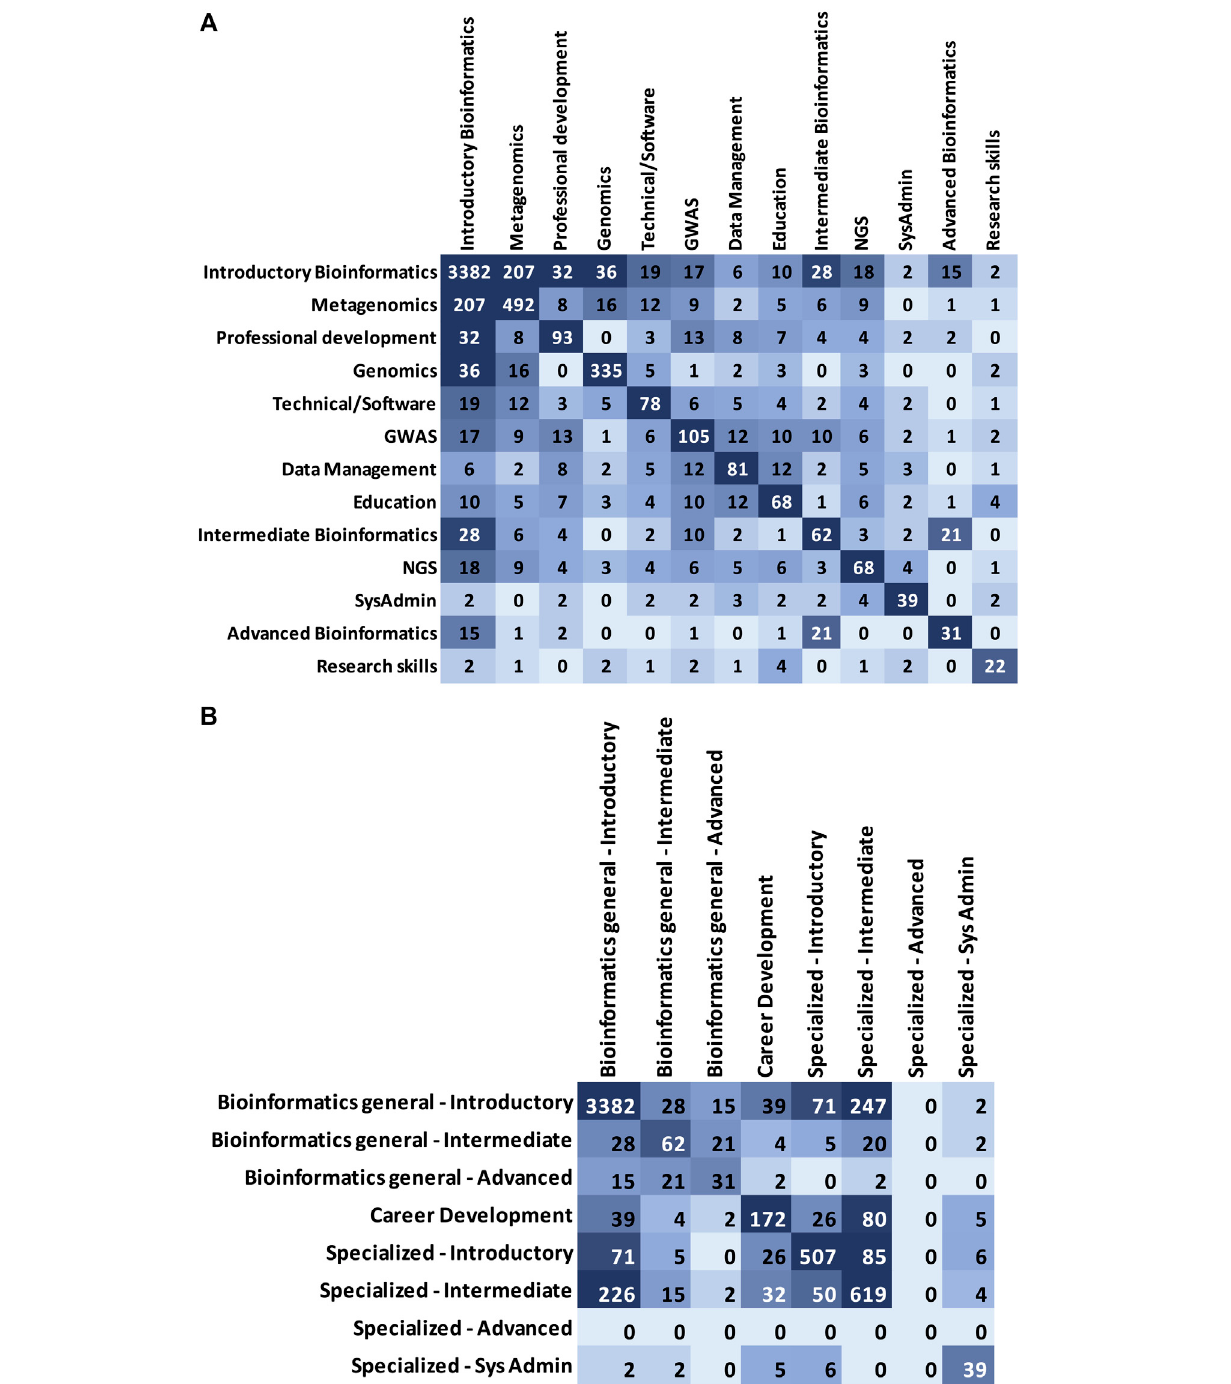
Frontiers in Education |